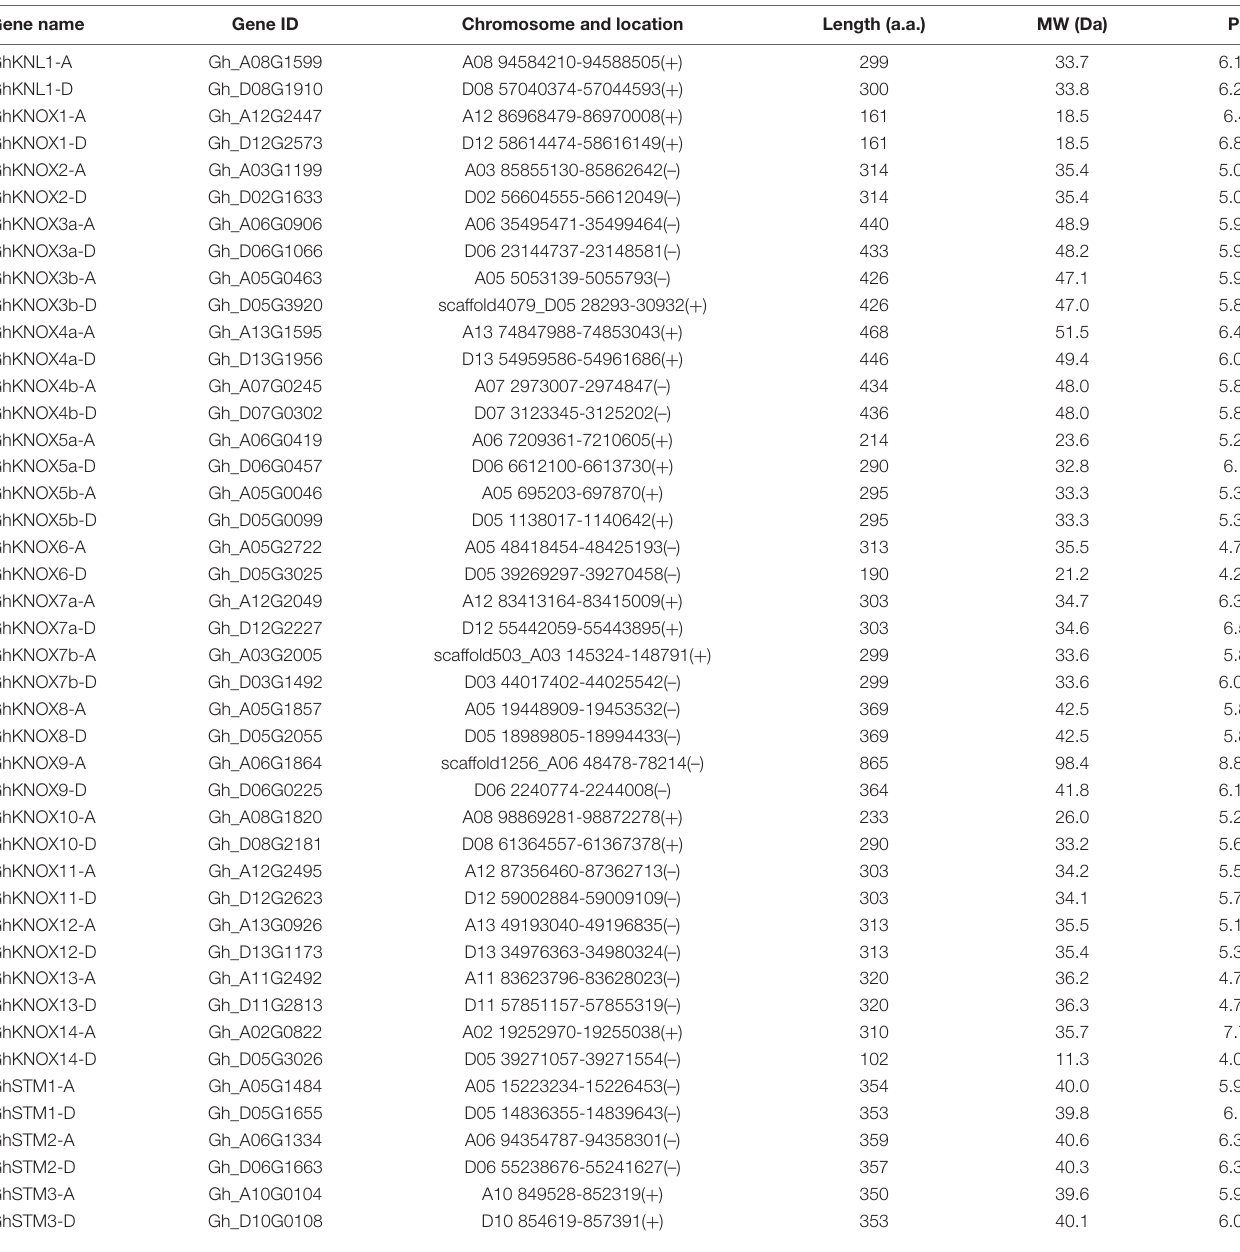
TABLE 1 | Genomic information for Gossypium hirsutum KNOX family